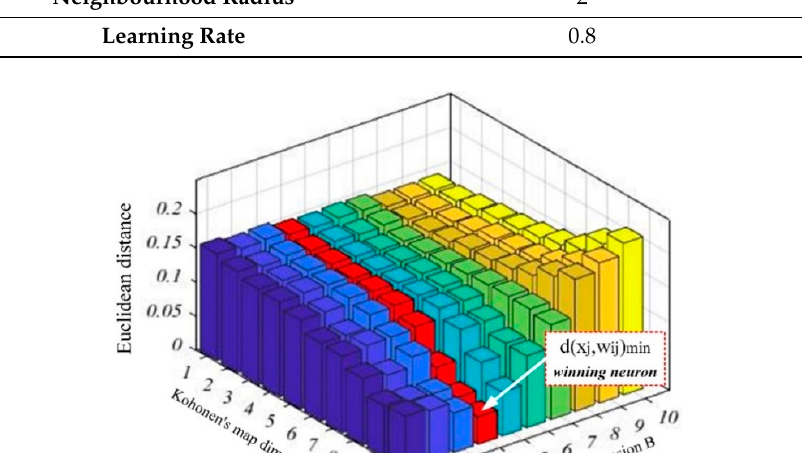
Figure 9. Illustration of the behaviour of the Kohonen Network (KN) under training.